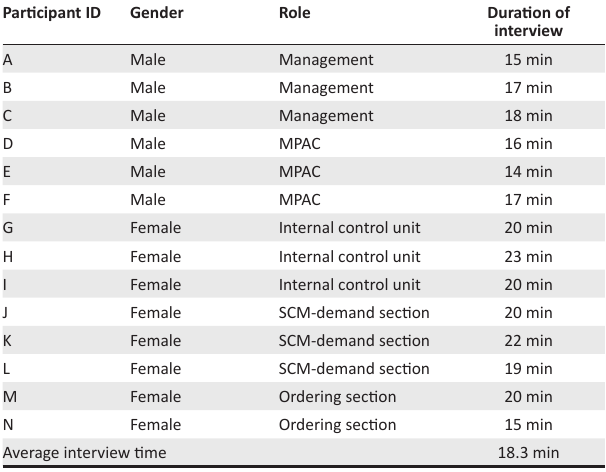
TABLE 1: Summary of the study sample.